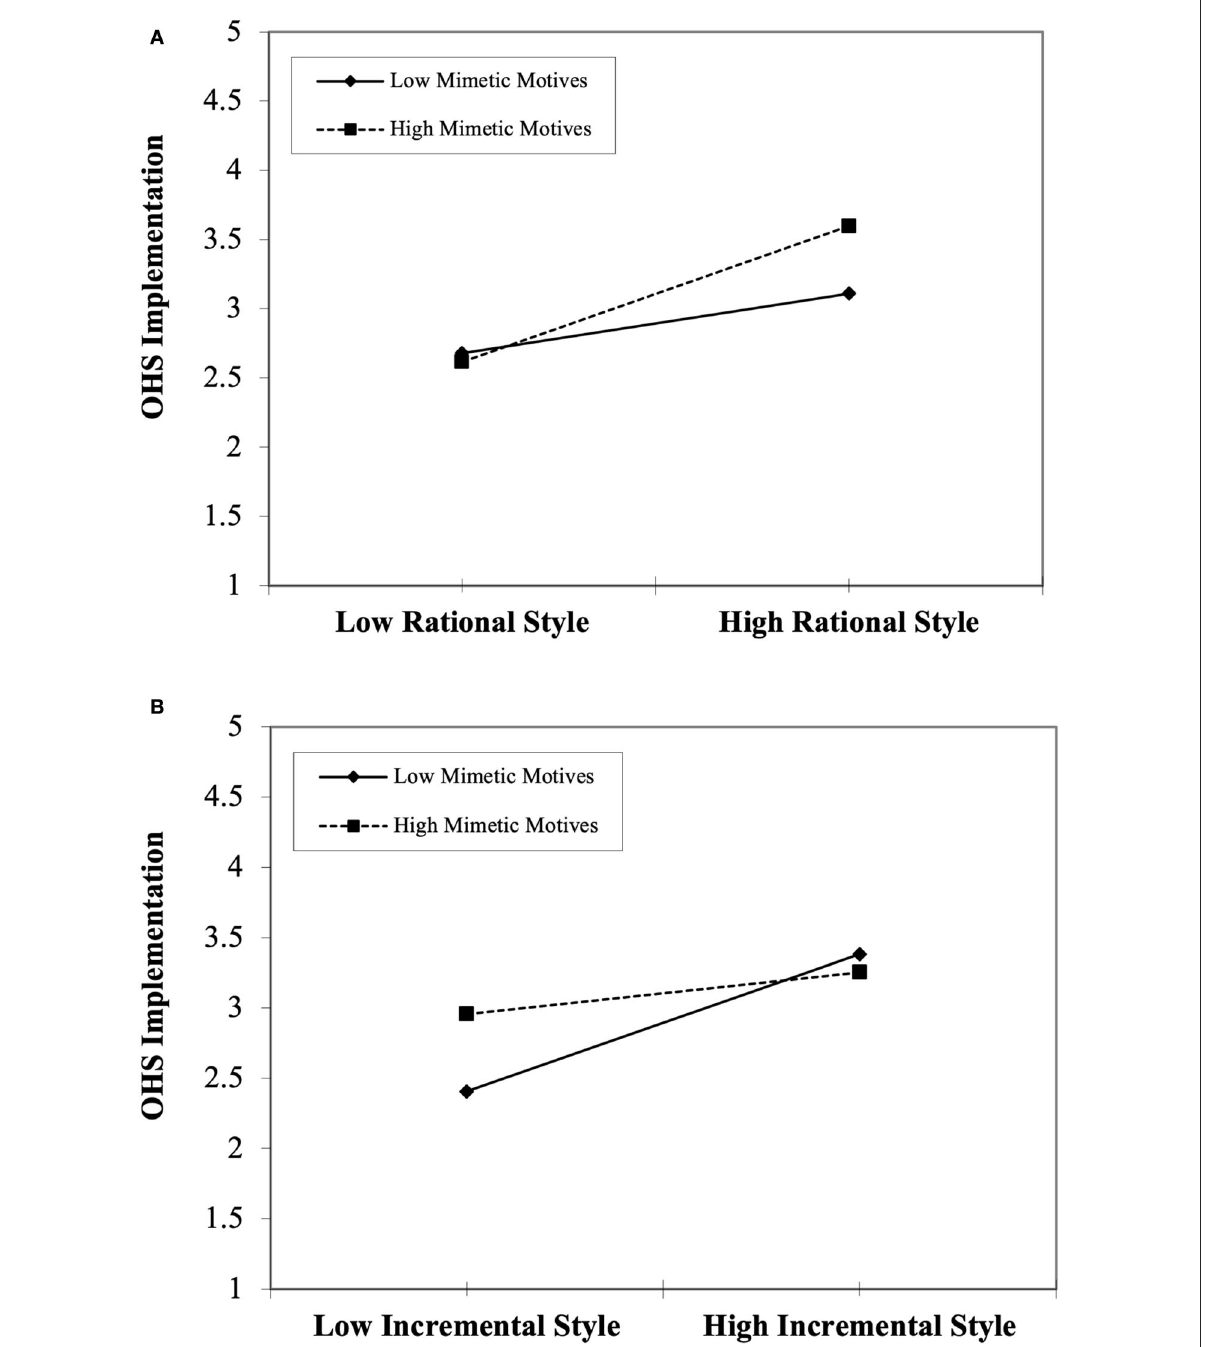
the implementation process requires a longer time for